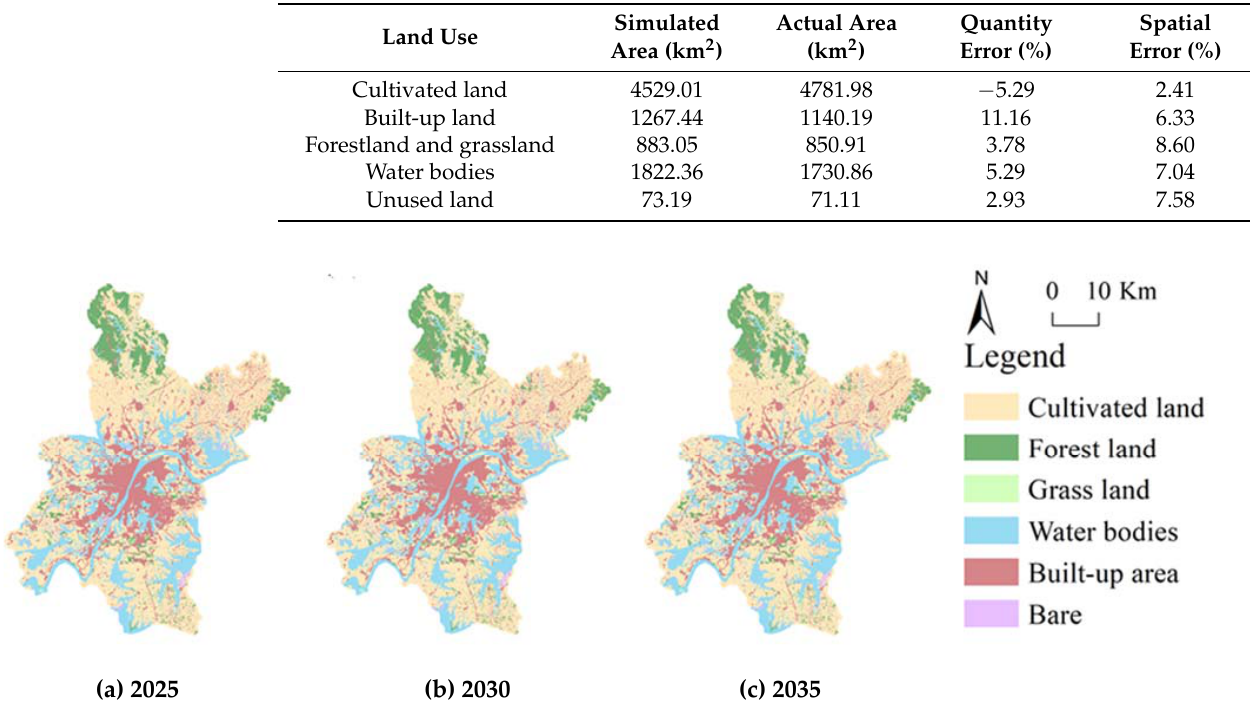
Table 2. Analysis of land-use simulation errors of Wuhan City in 2020.